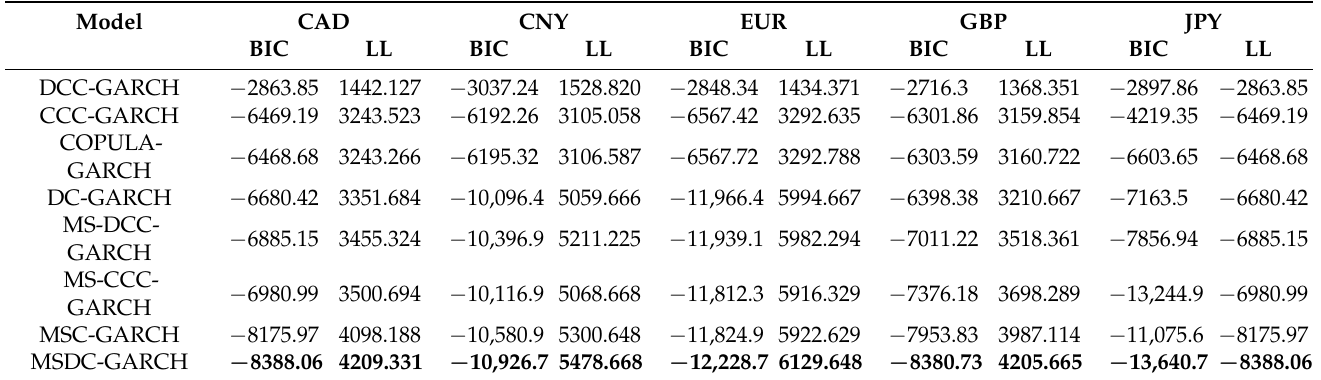
Table 10. BIC and Log-likelihood (LL) values for different models fitted to the one-day returns of five currencies. Model